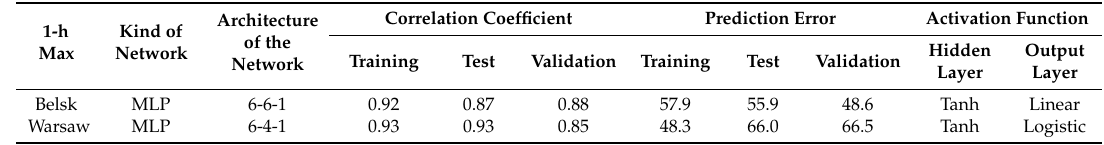
Table 1. Characteristics of the selected neural networks.